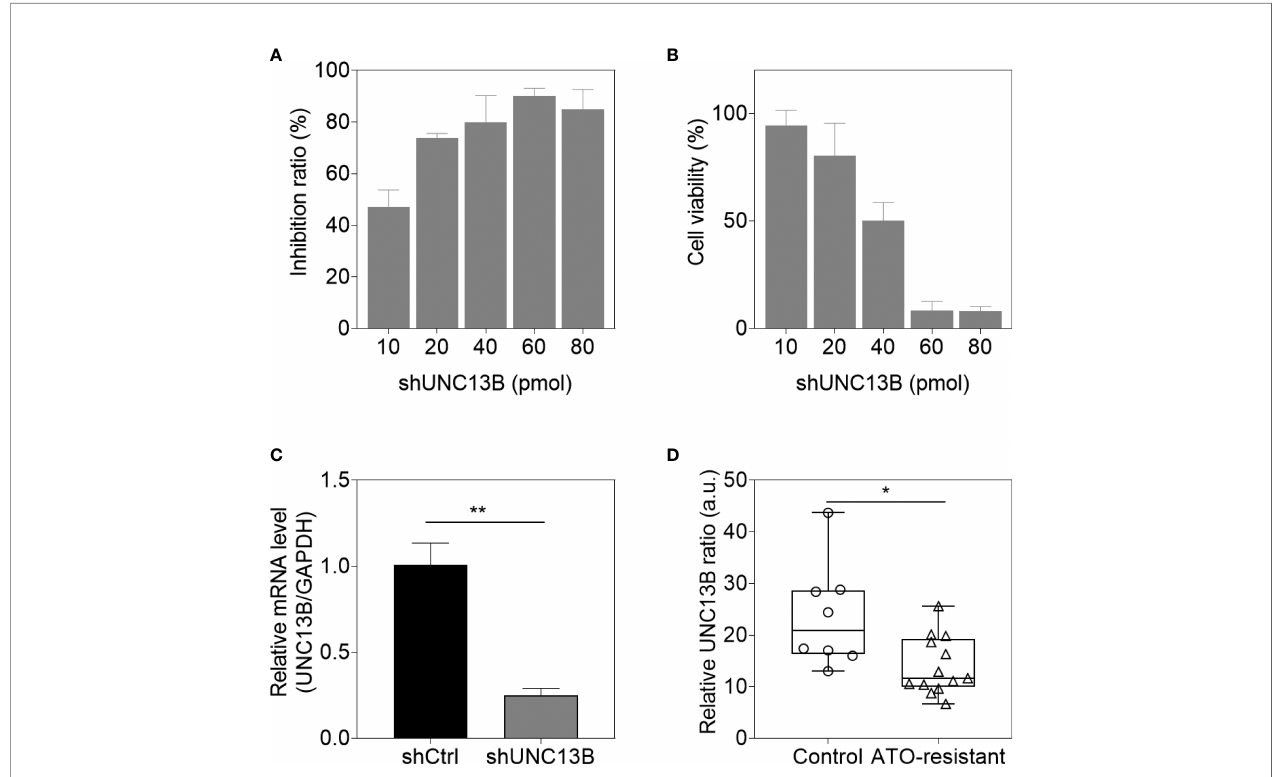
FIGURE 1 | UNC13B expression of arsenic trioxide (ATO)-resistant K-562 cells after UNC13B knockdown. Cell viability (A) and transfection ef fi ciency (B) were identi fi ed 48 h after transfection in the range of 10 pmol to 80 pmol shUNC13B. (C) The cells were analyzed 3 days post-knockdown via quantitative PCR. (D) Transcriptional levels of UNC13B were identi fi ed in ATO-tolerance clinical samples (n=13), control group referred to paracancer tissues (n=8). * p < 0.05, ** p <